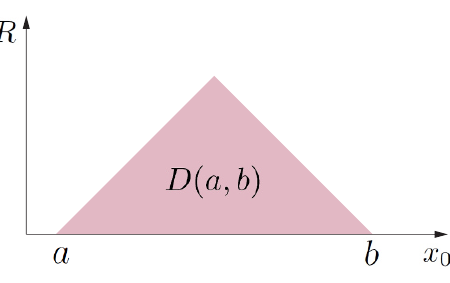
Figure 3 . The set D ( a; b ) of allowed values of the parameters x 0 , R